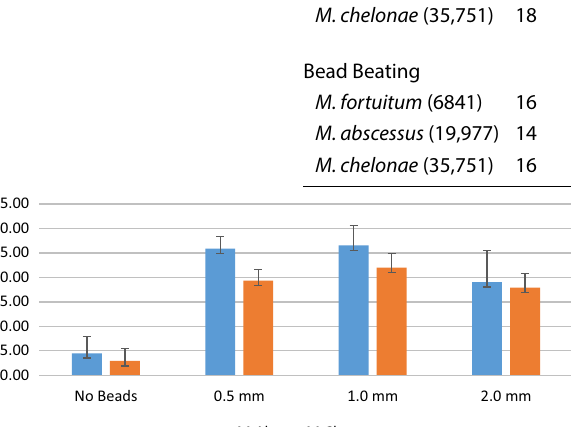
Table 2 Qubit Assay results of Proteins extracted with 15% ACN as extraction solvent using sonication and bead beating as lysis method for ~ 5 mg wet weight